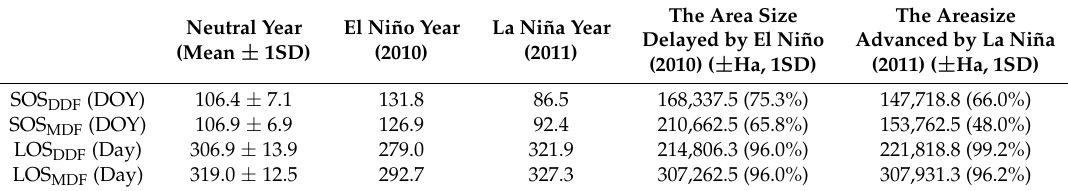
Table 2. Results of phenological metrics difference during extreme climate events across two forest types in Lampang, Northern of Thailand. The percentage showing the pixels which significant different in temporal between average neutral years and ENSO